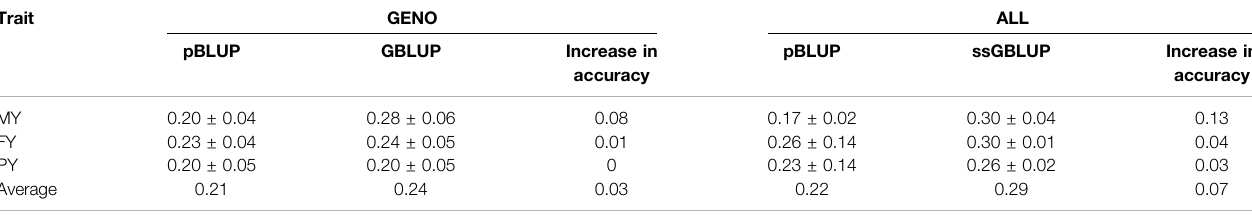
MY, milk yield; FY, fat yield; PY, protein yield.